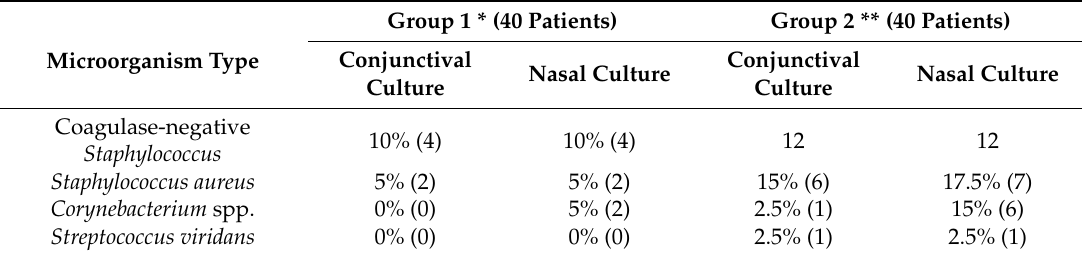
Table 2. The number of cultured organisms 10 min after performing the Schirmer test in groups 1 and 2 for both conjunctival and nasal